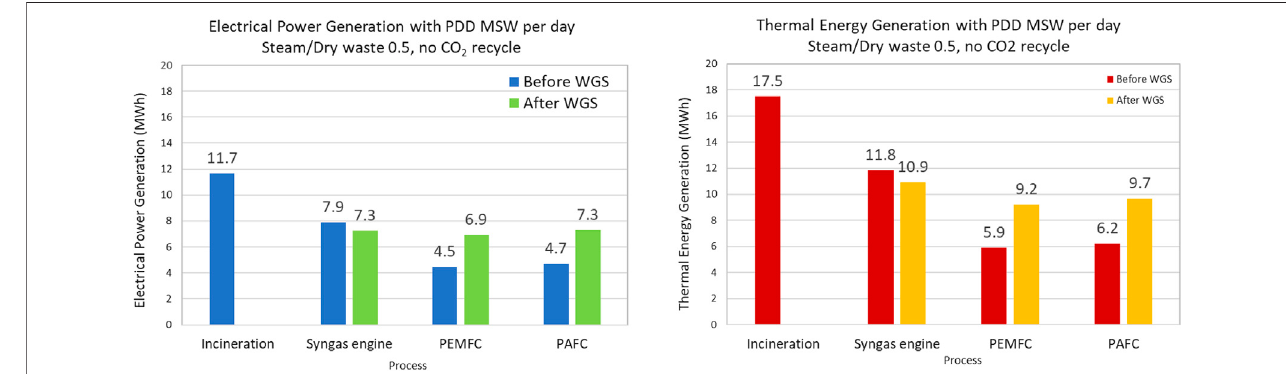
FIGURE 13 | Electrical power and thermal energy generation from four types of systems (incinerator, syngas engine, PEMFC, and PAFC). Note that syngas generation kinetic data are taken from Zheng et al. (2018).